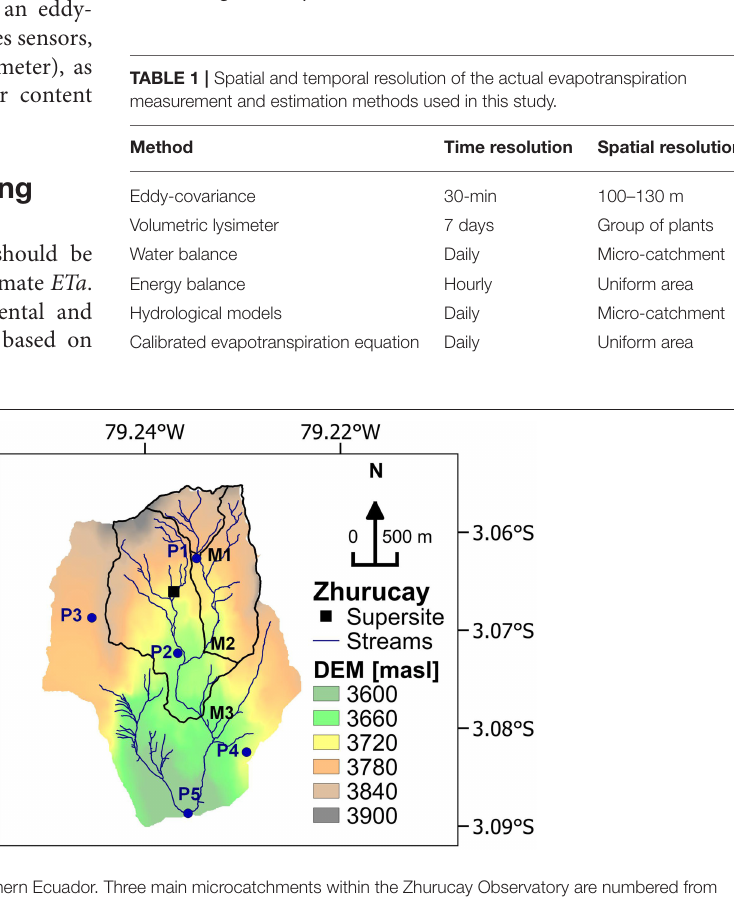
Frontiers in Earth Science |